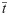
Theoretical expectation of the average lifespan of a new gene t¯.The analytical expression shows that t¯, measured in units of Nτ¯, increases faster than exponential as the average number of available hosts S¯ decreases. The dashed line represents the time to fixation of a neutral gene, which means that under small S¯, once established, the gene can be maintained in the population for much longer than the typical epidemiological timescale (or for much longer than the simulation period of 200 years in our model). The average lifespan Tnew obtained from the computational model will always be considerably smaller than the theoretical expectation t¯ derived under the assumption that other factors remain constant, in particular the average number of hosts S¯ that are susceptible to the invading gene. The general trend of increased persistence with lower S¯ will hold however for the full numerical system and for finite time windows.